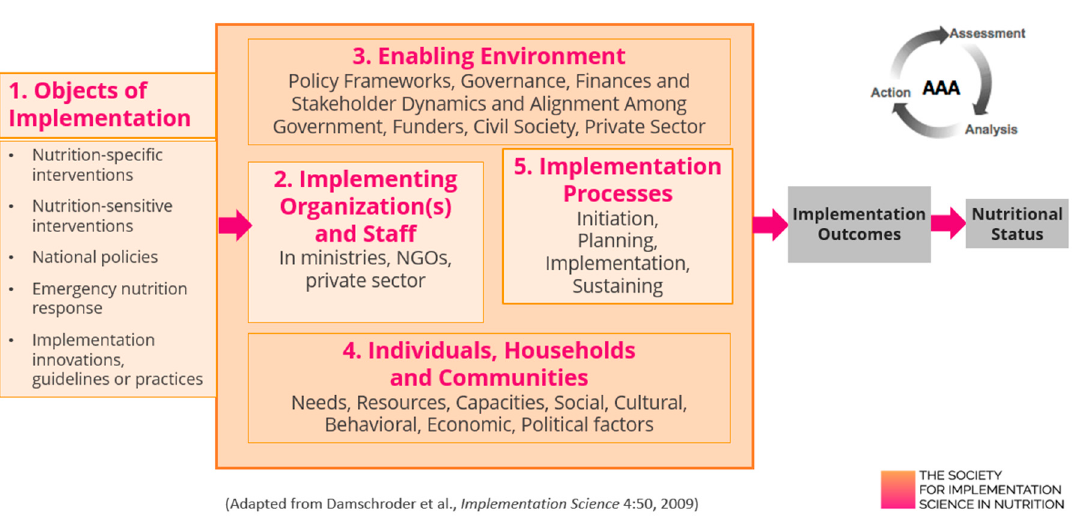
Figure 3. Domains of implementation science in nutrition framework. Source: SISN website— https://www.implementnutrition.org/sisn-framework/ (accessed on 12 December 2021)